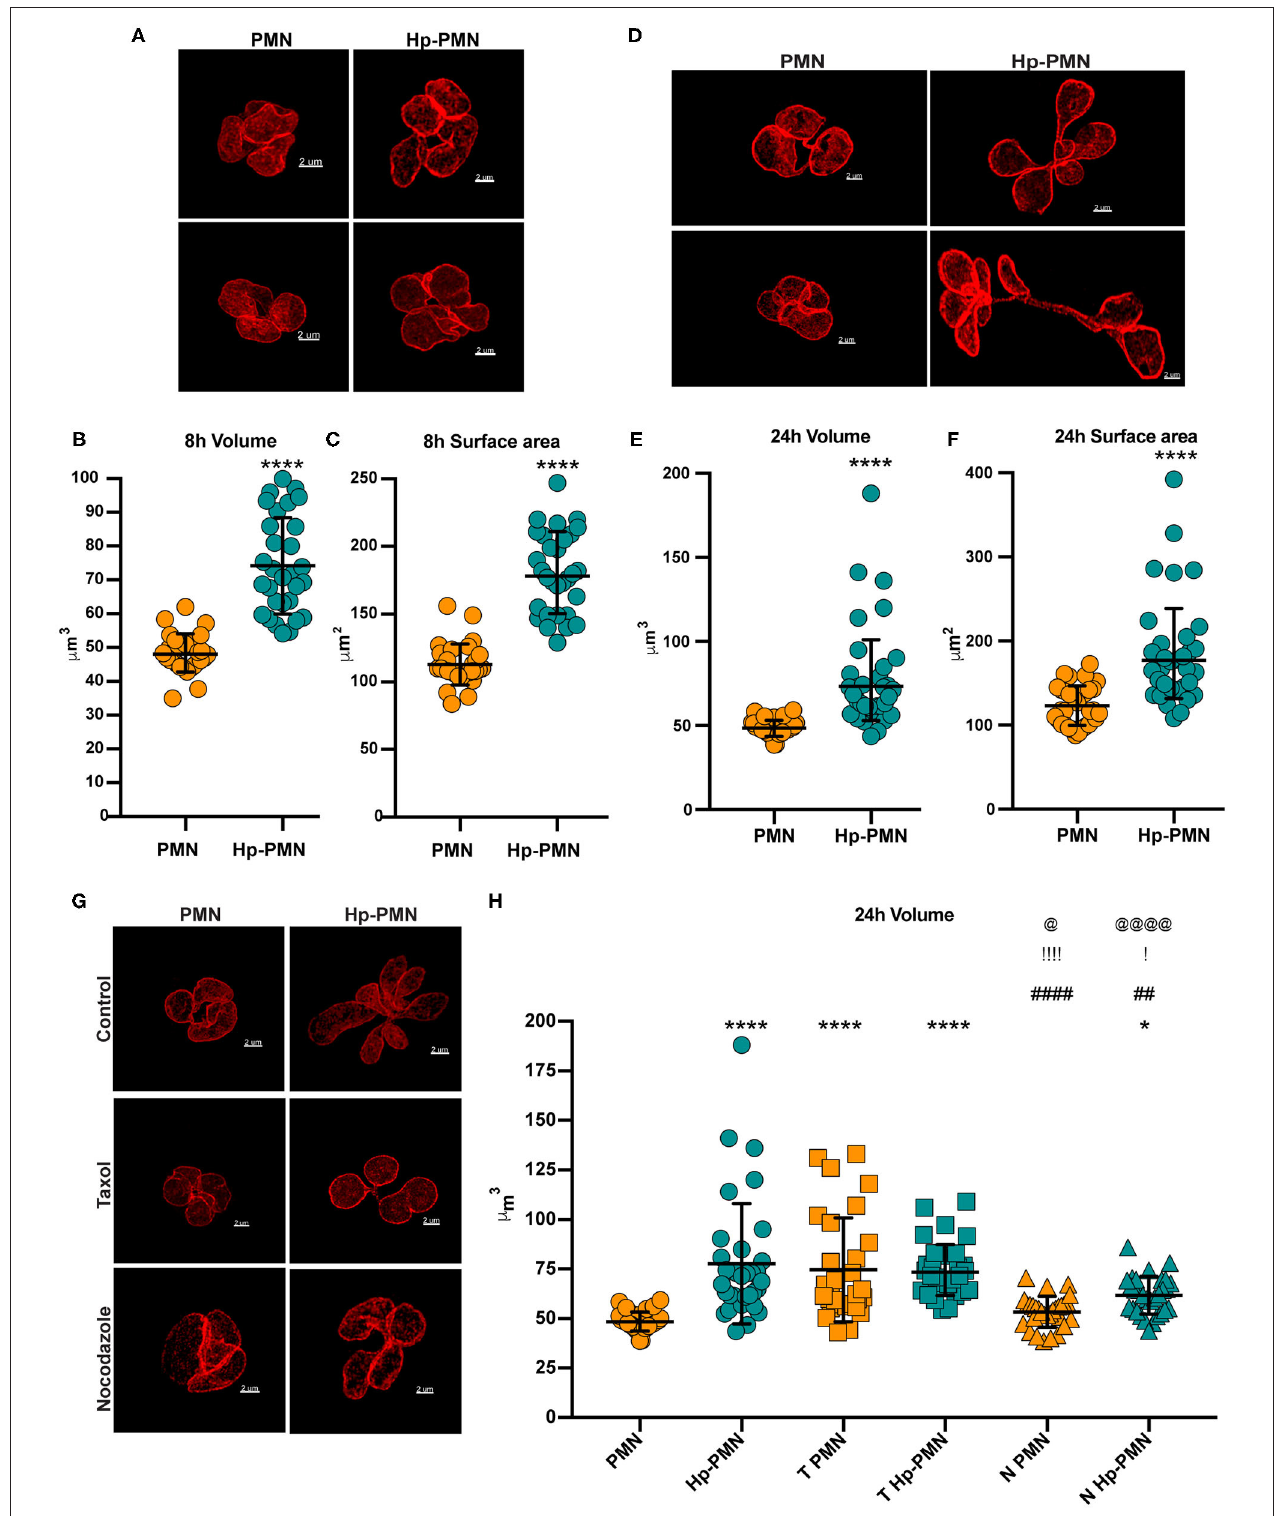
FIGURE 7 | H. pylori infection and microtubule dynamics alter nuclear volume. Uninfected and infected PMNs were stained to detect LBR (red) after 8h (A–C) or 24h (D–H) . As indicated in (G,H) , cells were also treated with taxol (T) or nocodazole (N) at time zero. (A,D,G) Representative 3D reconstructions of STED Z-stacks. Scale